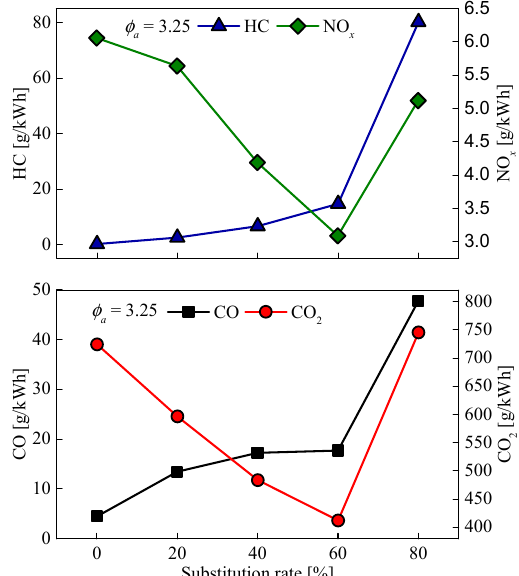
Figure 8. Comparison of emissions level with different substitution rates at 1600 rpm, 27.1 N·m.